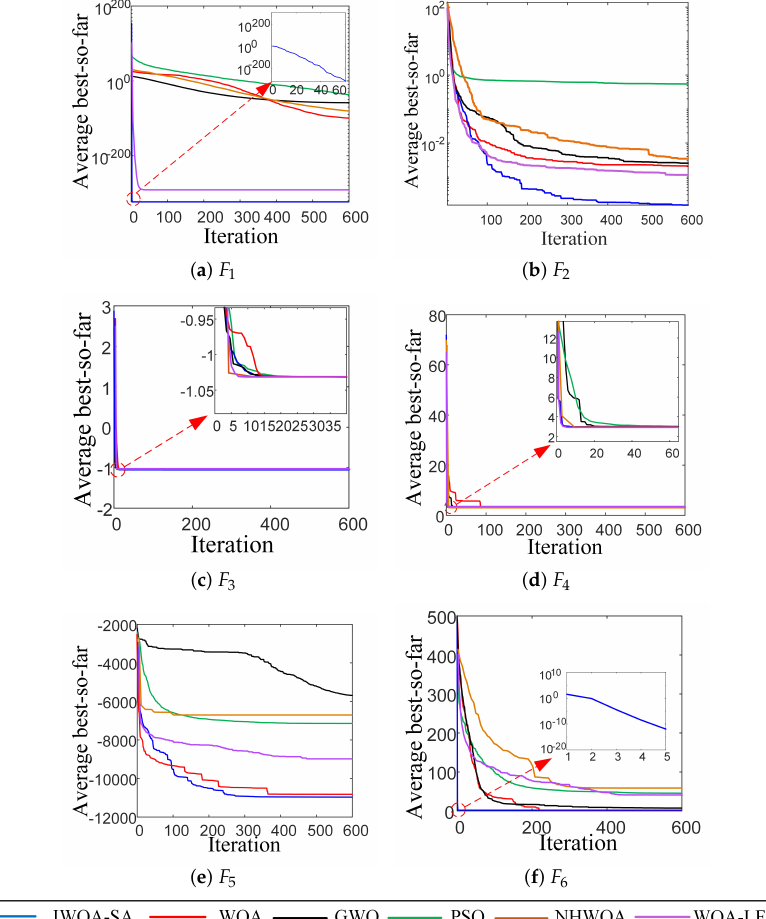
Figure 5. Convergence curves of the IWOA-SA, WOA, GWO, and PSO algorithms. ( a ) F1, ( b ) F2, ( c ) F3, ( d ) F4, ( e ) F5, ( f )